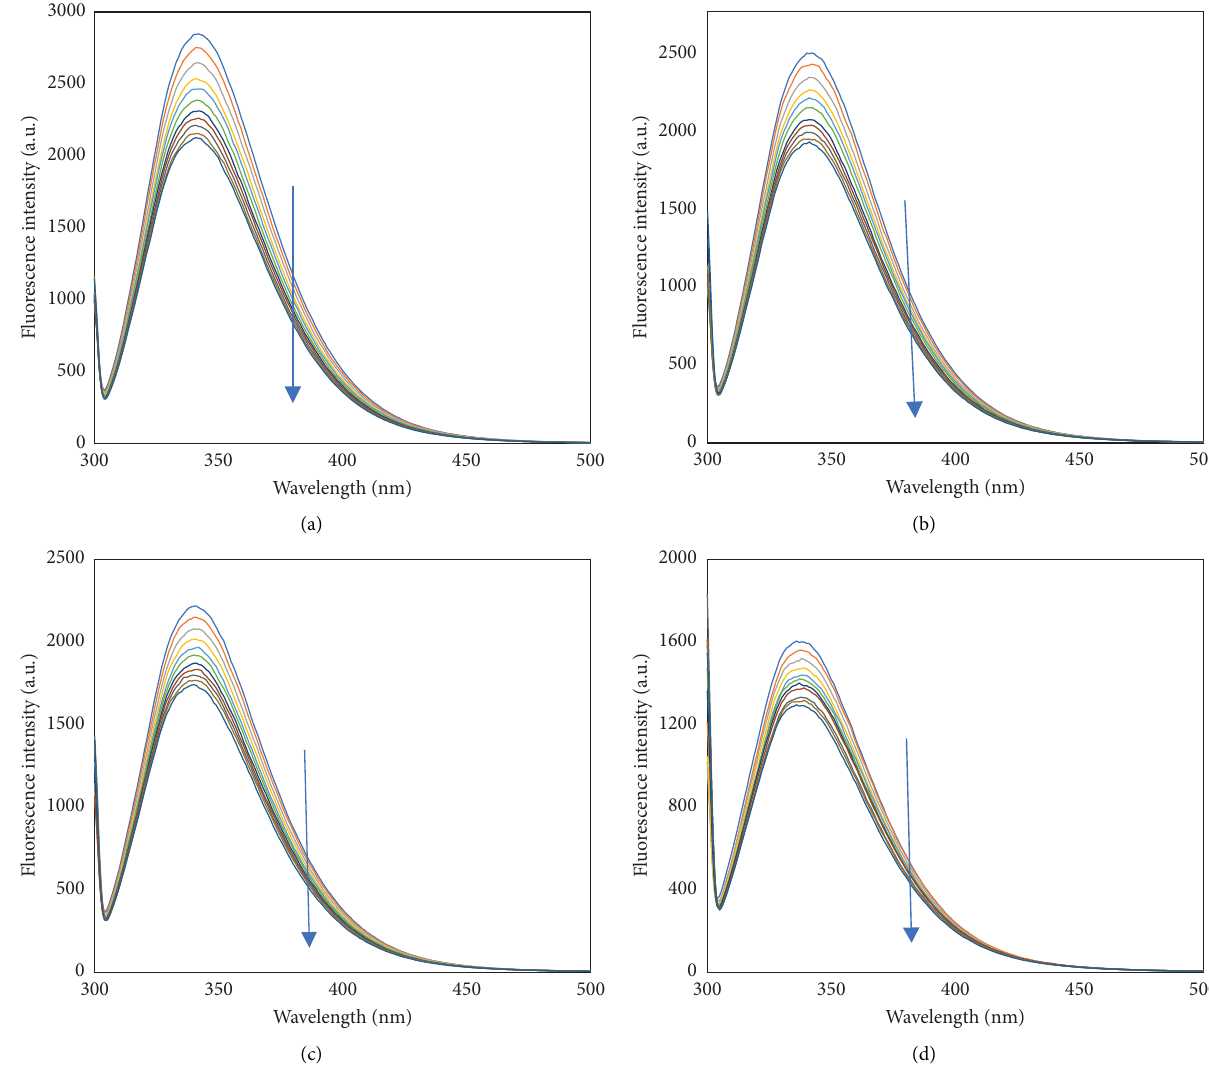
Figure 2: Fluorescence emission spectra of BSA without and with cuminaldehyde that were obtained after IFE correction at (a) 25, (b) 35, (c) 45, and (d) 55 ° C in a 20mM tris bufer of pH 7.4 at 25 ° C. Te concentration of cuminaldehyde was varied from 0 to 200 μ M at a constant increment of 20 μ M, and the concentration of BSA was 3 μ